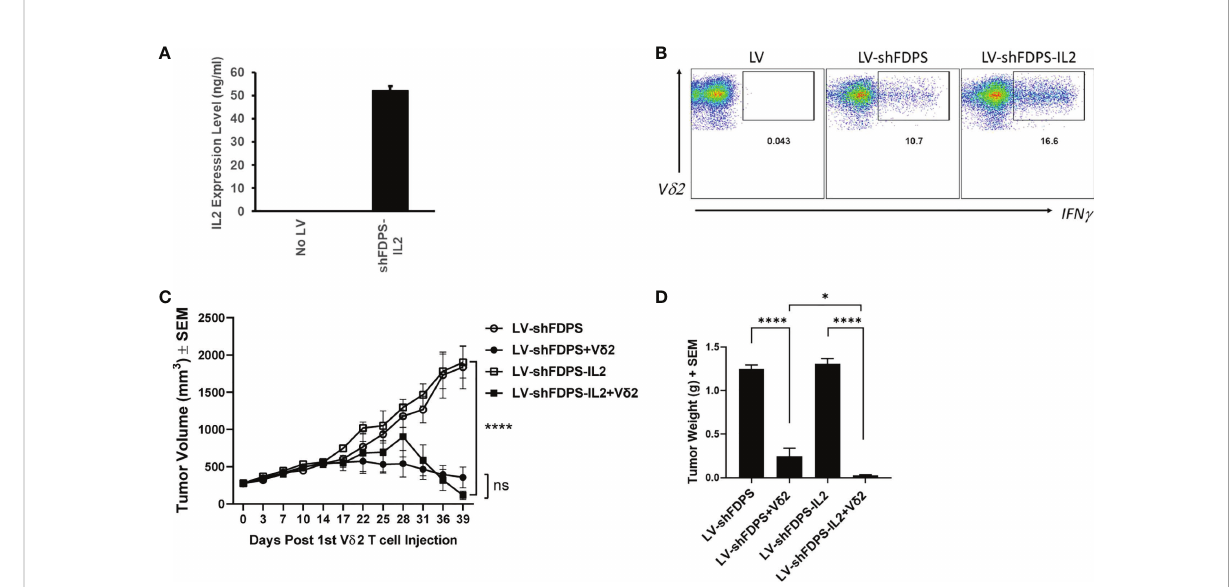
FIGURE 4 V d 2 T cells suppress the growth of PC3 prostate carcinoma tumors transduced with a lentivirus expressing IL-2 and a shRNA targeting FDPS. (A) ELISA analysis of secreted IL2 expression by PC3 cells transduced with LV-shFDPS-IL2. (B) Representative fl ow cytometry dot plots from PC3 cells transduced with LV-shFDPS or LV-shFDPS-IL2, followed by co-culture with V d 2 T cells for 4 h. The gated region indicates the V d 2 and IFN g positive population. The percent positive of IFN g producing cells was 10.7 (LV-shFDPS) and 16.6 (LV-shFDPS-IL2). (C) Tumor volume of PC3 cells transduced with LV-shFDPS or shFDPS-IL2. In mice treated with V d 2 T cells, the tumor volume of PC3 cells transduced with LV-shFDPS was signi fi cantly decreased at the end of the study from 1900 mm 3 to 356 mm 3 and with LV-shFDPS-IL2 from 1835 mm 3 to 116 mm 3 (**** p